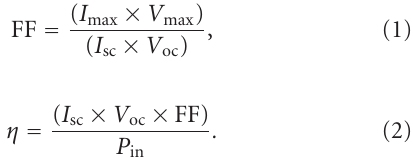
Figure 6: Photocurrent-photovoltage characterization of dye- sensitized solar cell using black rice dye immobilized on TiO 2 film with 35 W Xenon HID lamp as a light